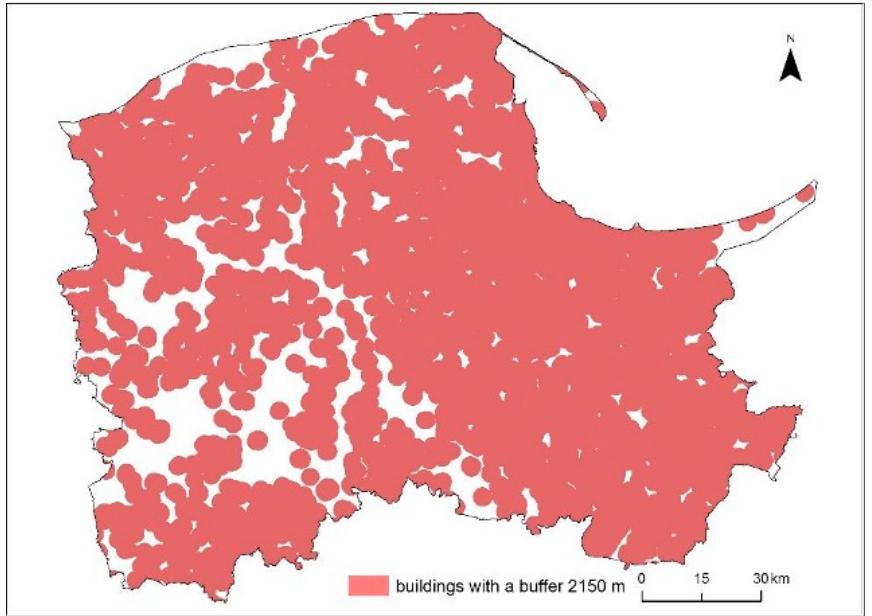
Figure 2. Buildings with a buffer of 2150 m (own elaboration).